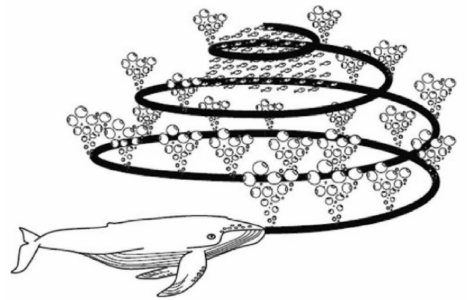
Figure 1. Bubble-net attacking behavior of humpback